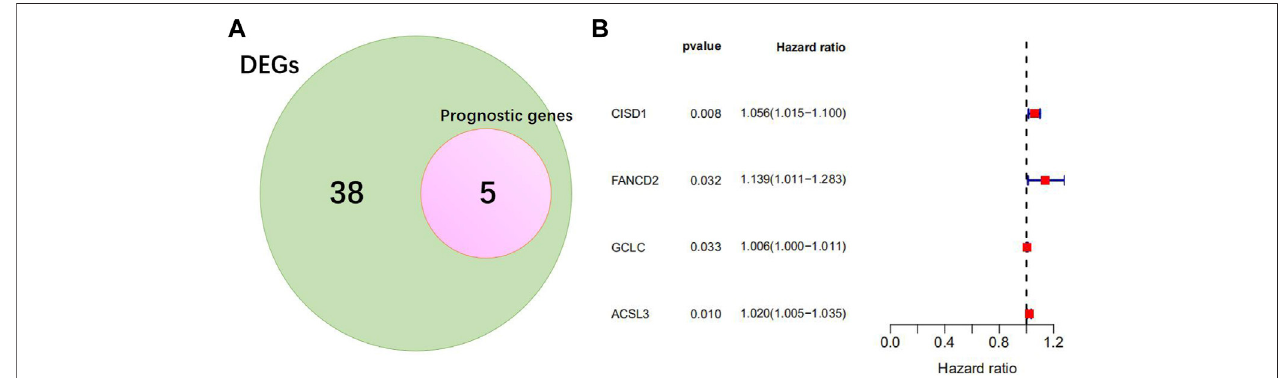
FIGURE2| Identi fi cationofthecandidateferroptosis-relatedgenesinTCGAcohort. (A) Venndiagramtoidentifydifferentiallyexpressedgenesbetweentumorand adjacent normal tissue that were correlated with overall survival (OS). The red circle represents the ferroptosis-related genes associated with prognosis, the green circle represents DEGs associated with ferroptosis. (B) Forest plots indicating results of the univariate Cox regression analysis between gene expression and OS. p -values < 0.05 indicate that ferroptosis-related genes are related to the prognosis of NSCLC. When the hazard ratio (HR) is > 1, the gene is considered a high-risk gene.